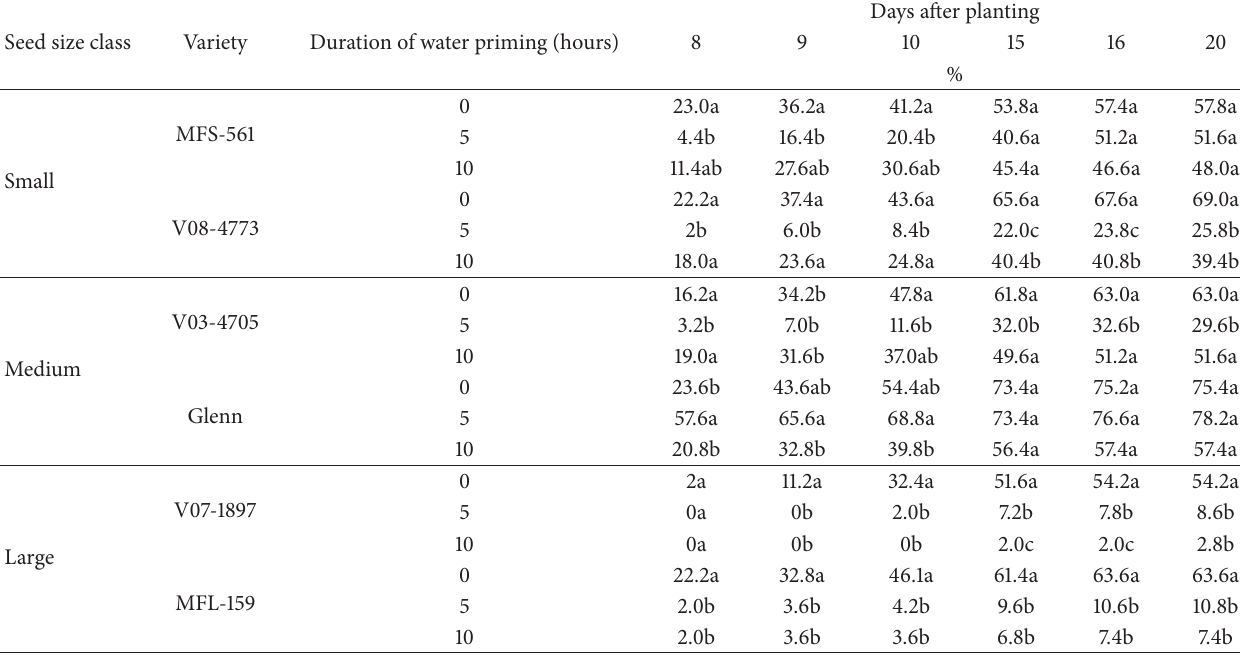
Table 6: Seedling emergence as a percentage of seeds planted in the field in 2014.